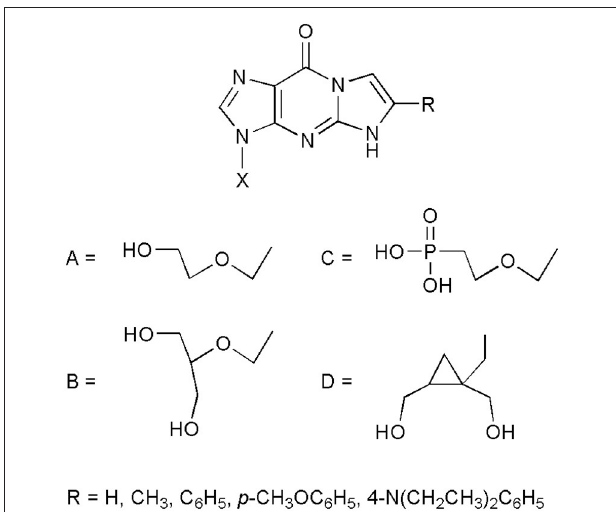
FIGURE 2 | Selected examples of antiviral acyclonucleosides derived from 1,N 2